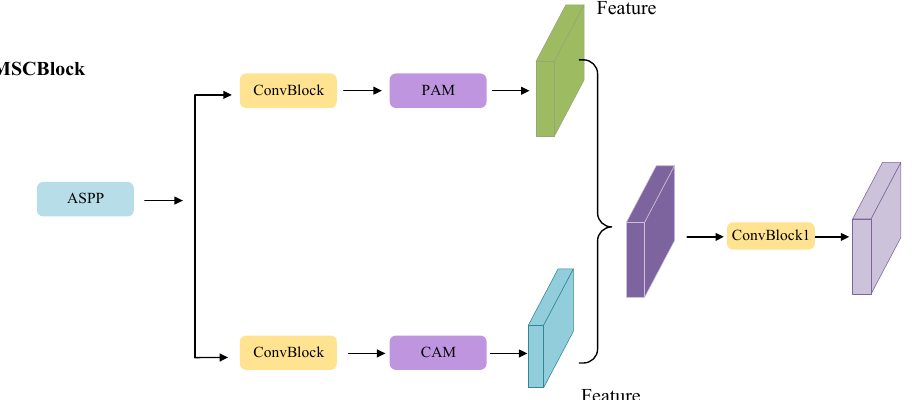
Figure 5. MSCBlock flow diagram. ConvBlock stands for convolution block and is composed of convolutional operation of kernel size 3, batch normalization operation, and Relu operation. ConvBlock1 represents a convolutional block composed of kernel size 1, batch normalization operation, and Relu operation.